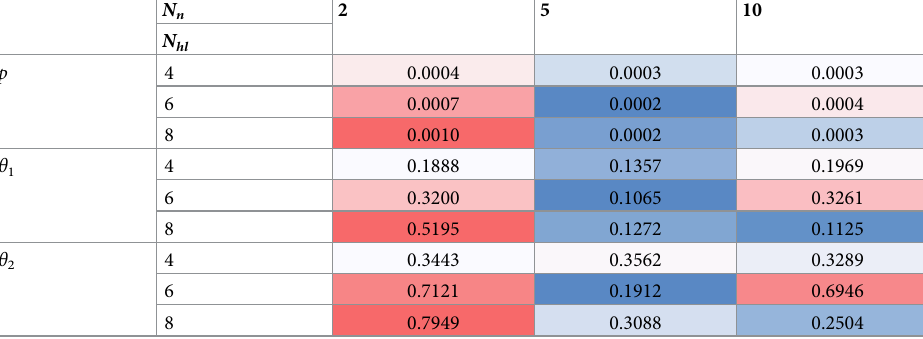
Table 3. Diffusivity equation—inverse modeling: PINN performance as function of hyperparameters. Relative L 2 error of p and percentage error of θ 1 and θ 2 for different number of hidden layers, N , and different number of neurons hl per layer, N n . The N tr is fixed at 250. Note that we pick the optimal hyperparameters, i.e., N hl = 6 and N n = 5 from the sensitivity analysis of the forward model. Results shown in this table are an average over 24 realizations. N n 2 5 10 N hl p 4 0.0004 0.0003 0.0003 6 0.0007 0.0002 0.0004 8 0.0010 0.0002 0.0003 θ 1 4 0.1888 0.1357 0.1969 6 0.3200 0.1065 0.3261 8 0.5195 0.1272 0.1125 θ 2 4 0.3443 0.3562 0.3289 6 0.7121 0.1912 0.6946 8 0.7949 0.3088